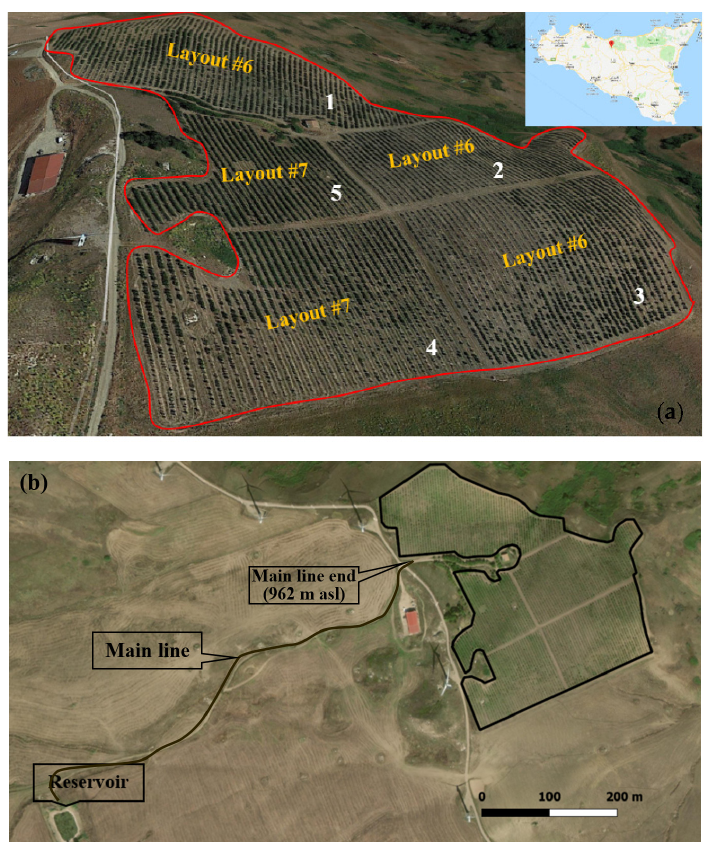
Figure 3. The MELIDIONALE apple farm (Sicily), ( a ) three-dimensional (3D) Google Earth view, actually subdivided into five cultivated sectors, and ( b ) two-dimensional (2D) Google Earth view of the apple farm, illustrating the reservoir location (859 m a.s.l.).